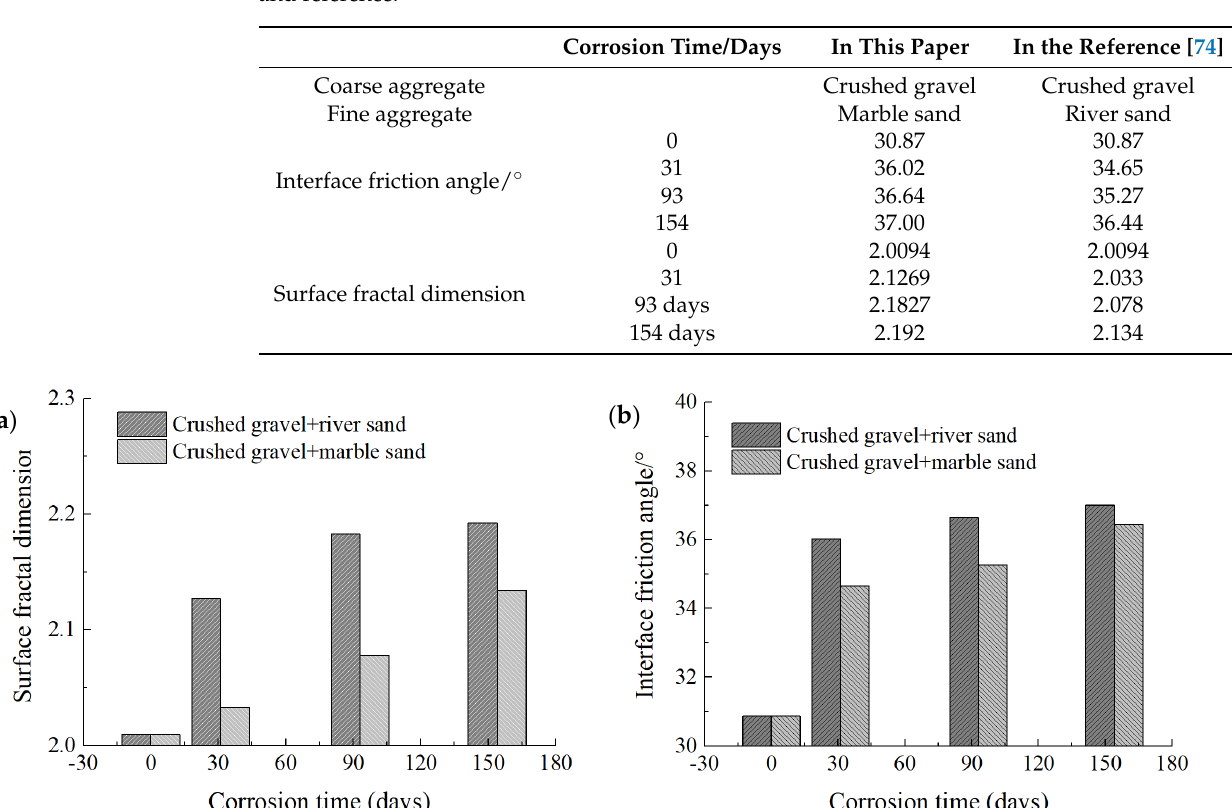
Table 5. Comparison of the friction angle of the interface and fractal dimension between this paper and reference.